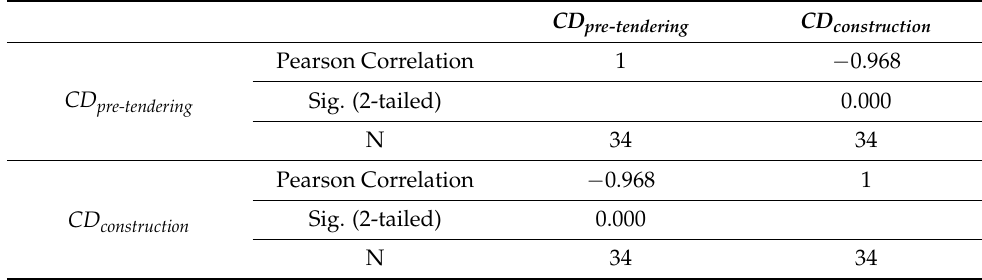
Table 3. Correlation test results.